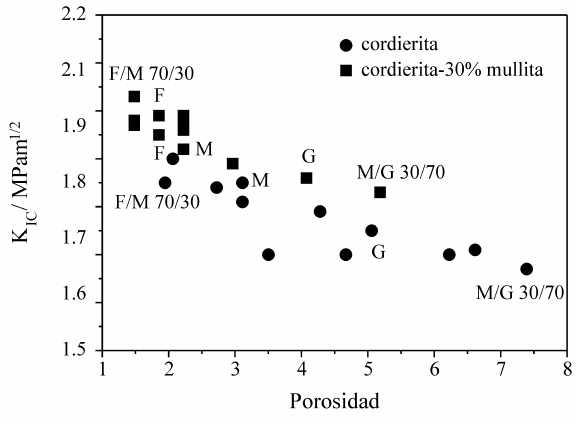
Figura 2. Variación del factor crítico de intensidad de tensiones (K IC ) de los materiales de cordierita y cordierita-30% mullita en función de la